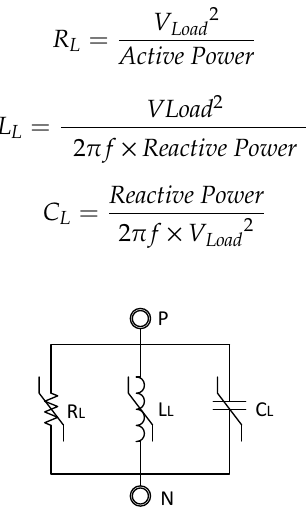
Figure 2. Constant power load.